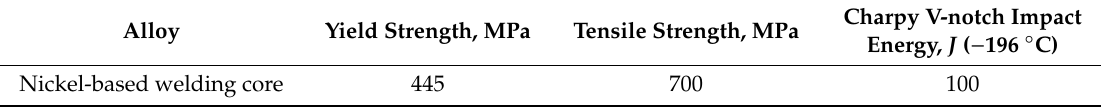
Table 2. Mechanical properties of welding